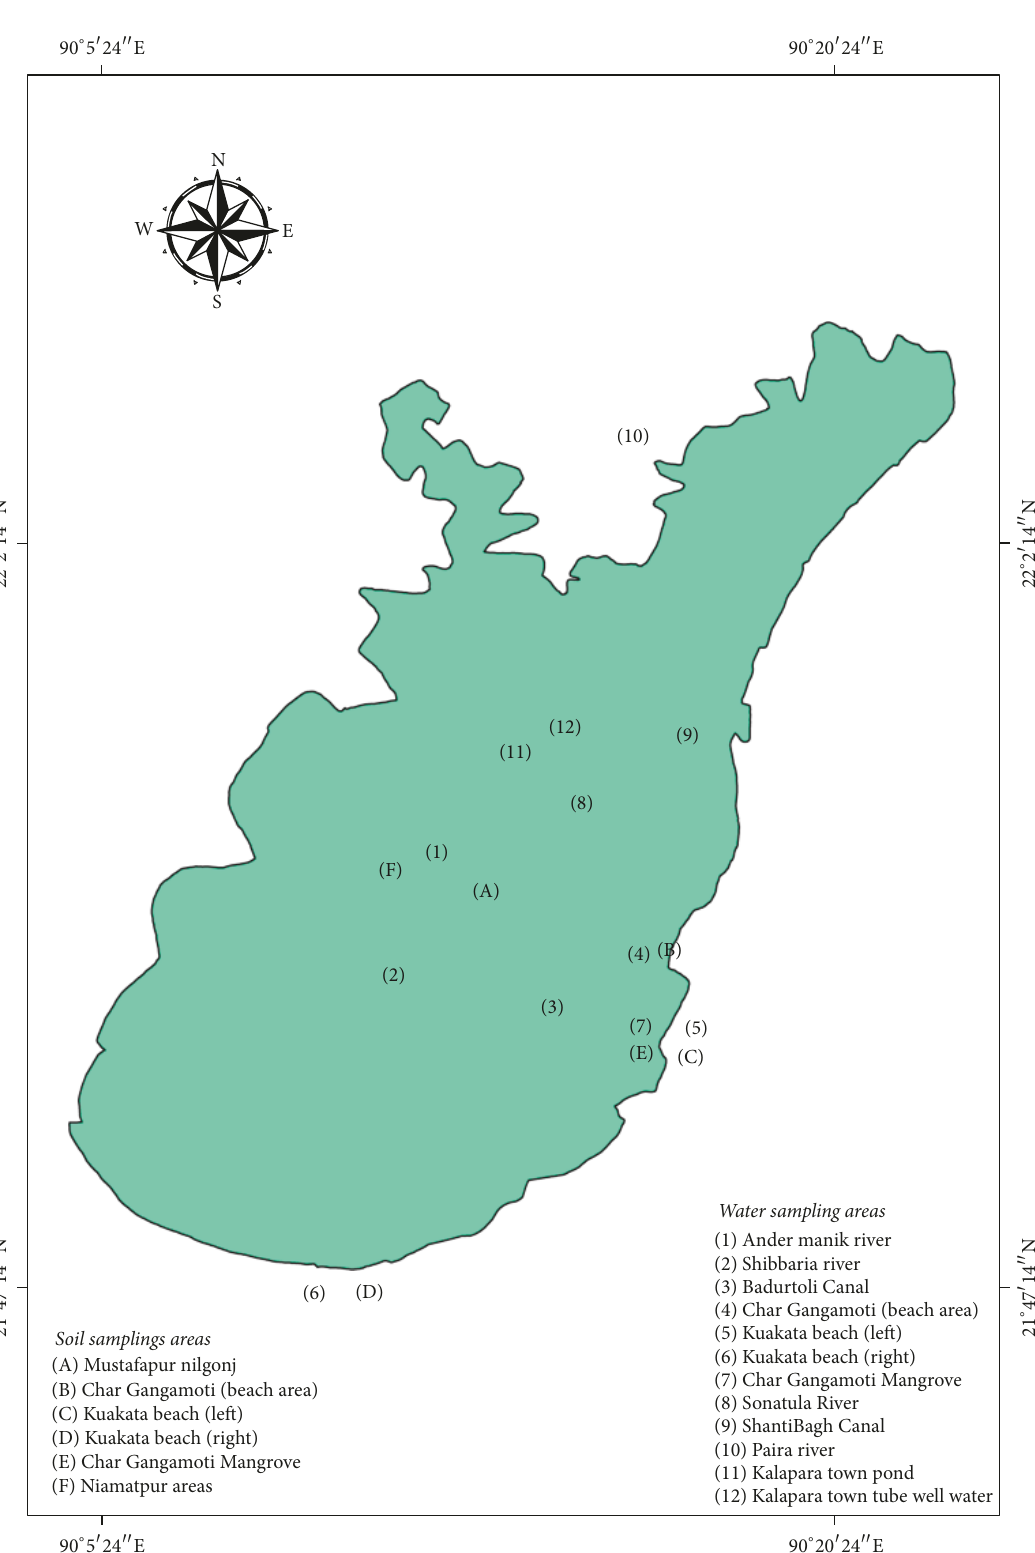
Figure 2: Sampling locations in the study